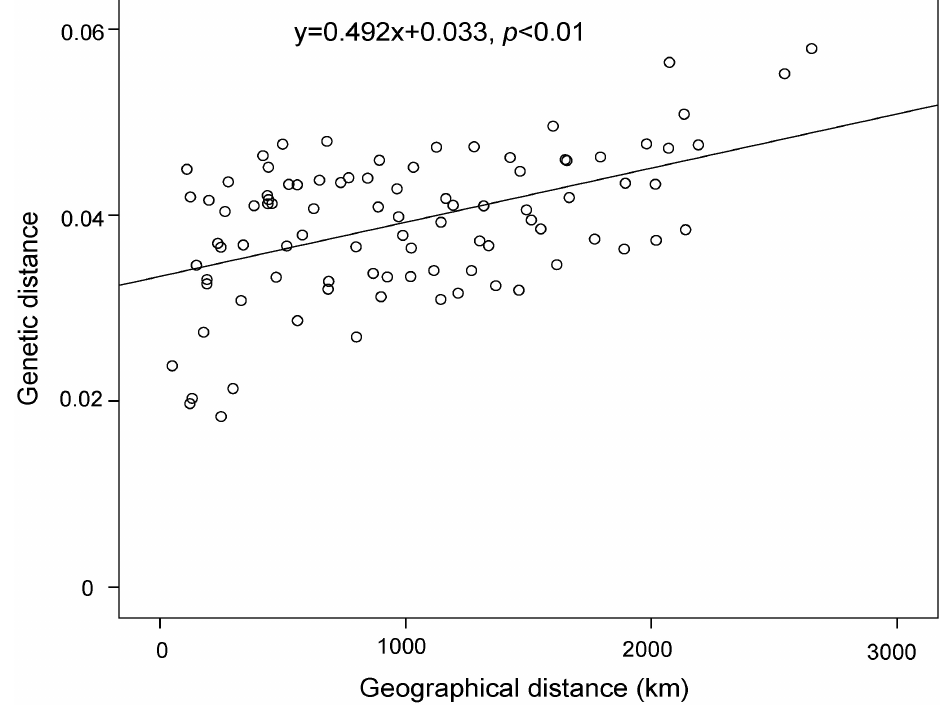
Figure 2. Correlation of pairwise genetic distance and geographical distance among the 14 sampled Gymnocarpos przewalskii populations.